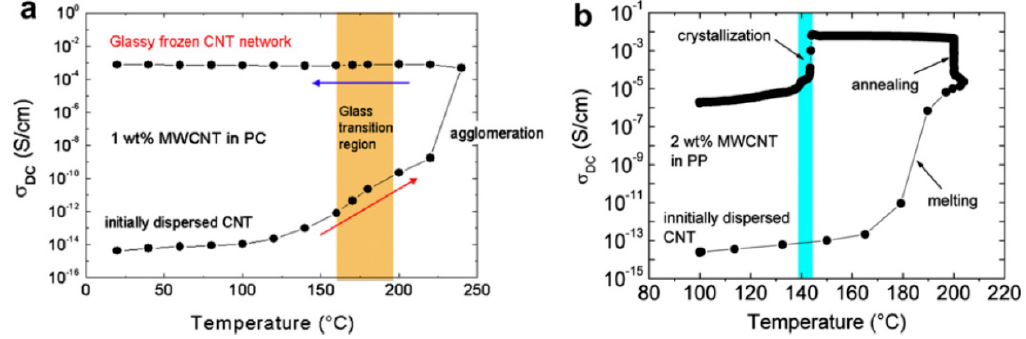
Figure 14. Electrical conductivity of ( a ) an amorphous and ( b ) a semi-crystalline polymer-MWCNT composite during heating-annealing-cooling cycles [8,67].